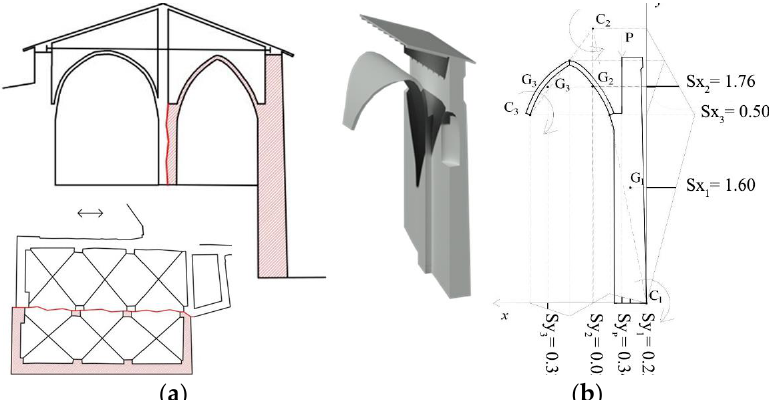
Figure 16. Representation of the wall mechanism: ( a ) 2D and 3D model extrapolated from the simplified volumetric; and ( b ) analysis of the south side wall, with graphical solution of the equilibrium conditions analysis for the calculation of the seismic coefficient.